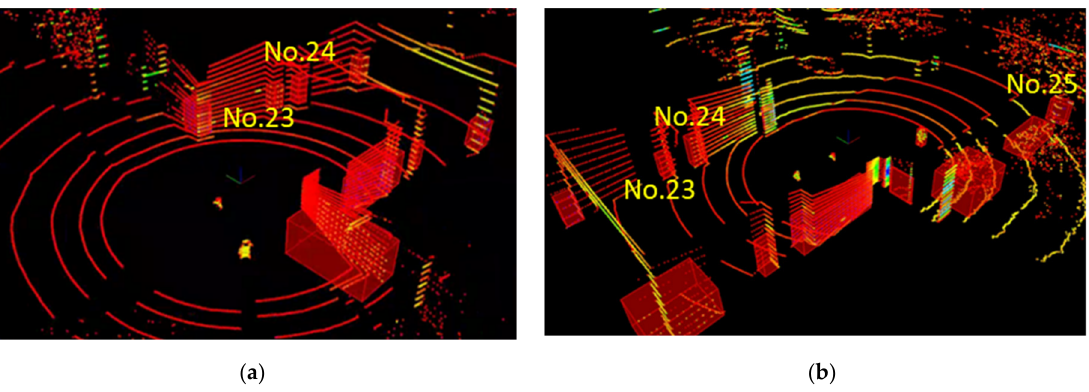
Figure 19. Single frame point cloud target detection results. ( a ) The 1742nd frame and No. 23 – 24 targets in Figure 18. ( b ) The 1856th frame and No. 23 – 25 targets in Figure 18.